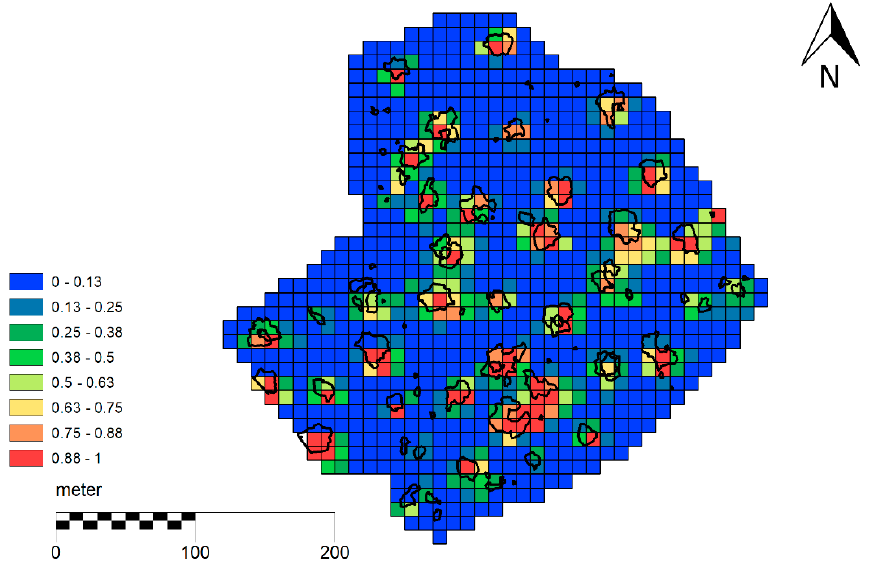
Figure 13. Treefall gap fuzziness map evaluated from the merged time series of 2015 and 2016 at the OS2 on a 10 m resolution grid. Reference treefall gap polygons are shown with black outline.